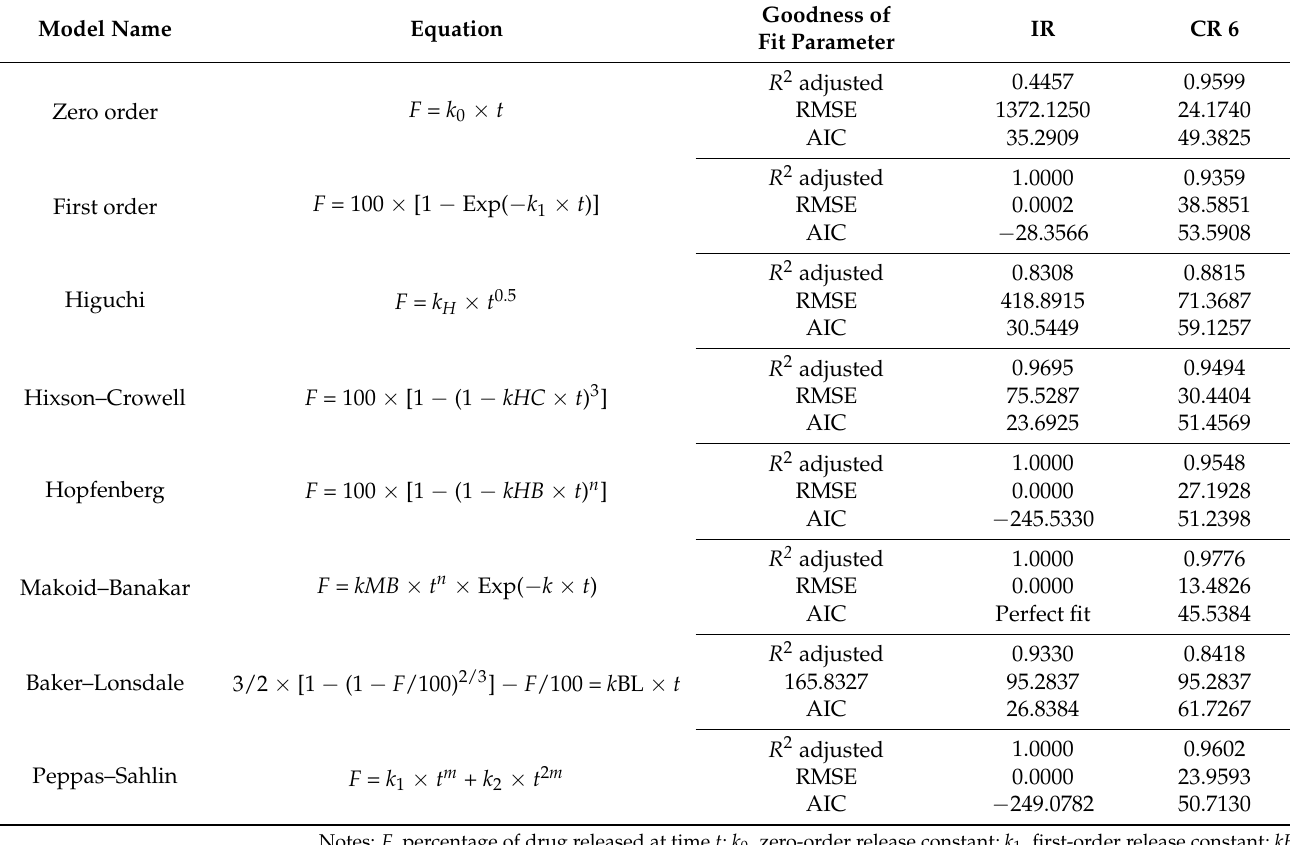
Table A1. Release parameters of fitted experimental data for cloprostenol IR and CR 6 tablets.